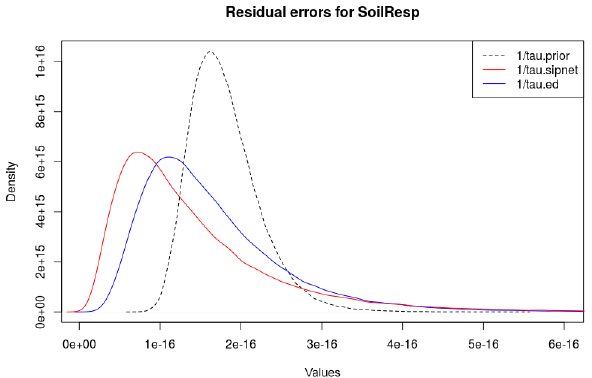
Figure A7. Posterior probability density distribution of variance (reciprocal of the precision, 1 /τ ) parameter of the soil respiration likelihood after emulator PDA.